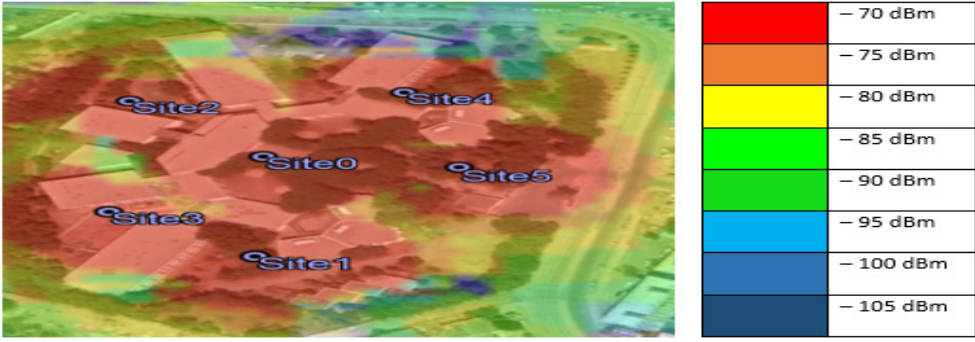
Figure A6. Prediction of power level coverage in ENST campus with six base stations.